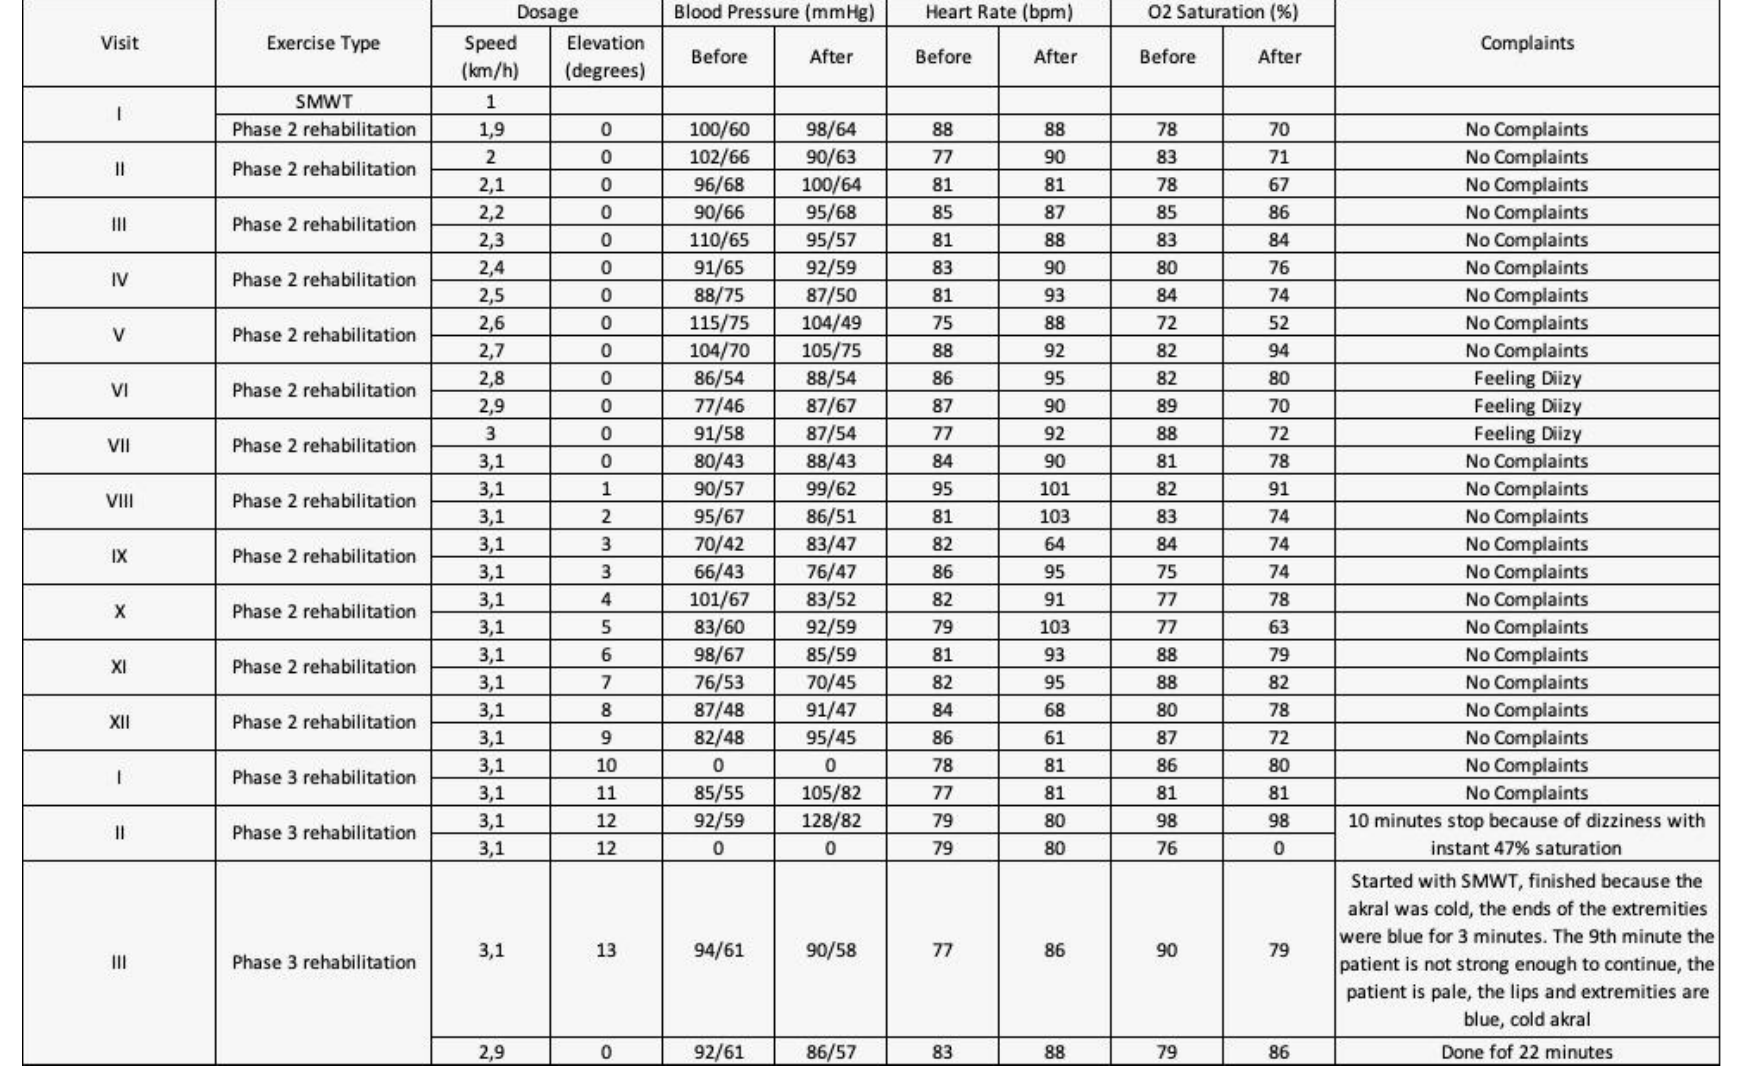
Table 1. Patient follow-up data during exercise